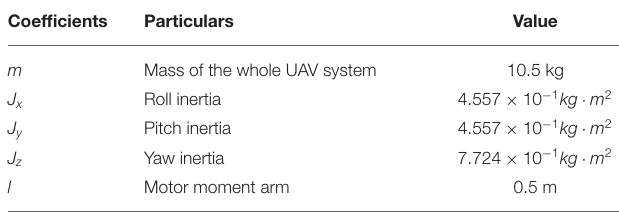
TABLE 2 | Coefficients in the simulation